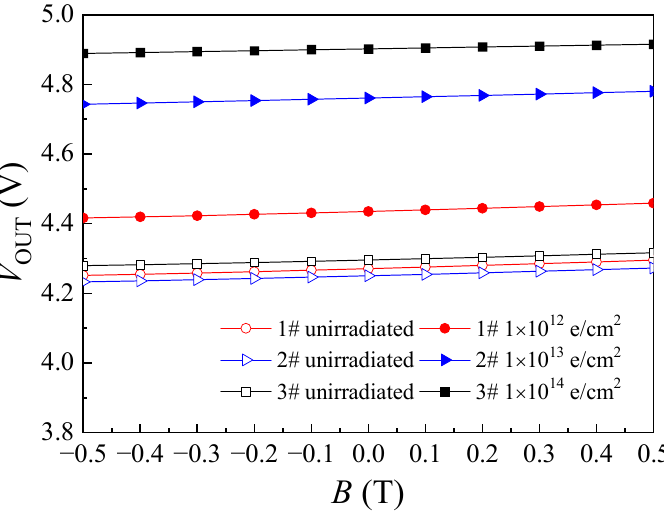
Figure 5. Relation curves of V OUT and B of SMSTs before and after electron irradiation.